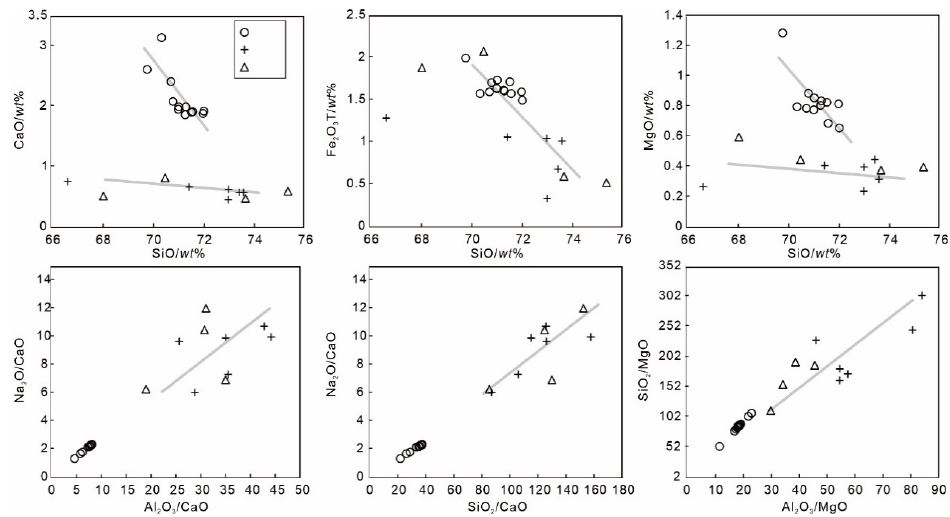
Figure 8. Harker diagram of the Wuzhutang granite from the Xuebaoding mining area, Sichuan Province, China. Data of the Pankou and Pukouling granites are from [38,39]. Compared with typical S- and I-type granites [66], the Wuzhutang granite was en- riched in Sr (333.62–441.3 ppm), which imparts partially adakitic properties to the samples (Sr/Y > 20, Y < 20 ppm; e.g., [67]), but with slightly lower Sr contents, significantly lower